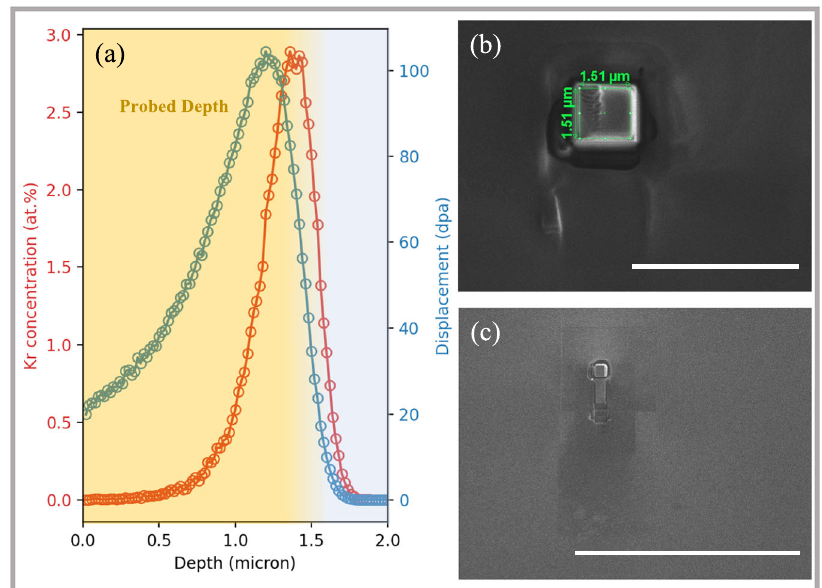
Fig. 1 The ion implantation pro fi le and the focused ion beam assisted sample liftout. a Plot of the expected dpa and injected ion concentration as a function of depth after 5 MeV Fe ion implantation. b SEM micrograph of the multi-re fl ection BCDI strain microscopy lift-out. Here, the initial rectangular-shaped platinum cap marks the lift-out region, and the approximate position of the BCDI sample is shown. The scale bar shown corresponds to 5 μ m. c SEM image of the fi nished sample with the location of the implanted layer mounted on a silicon wafer. The scale bar shown corresponds to 40 μ m.